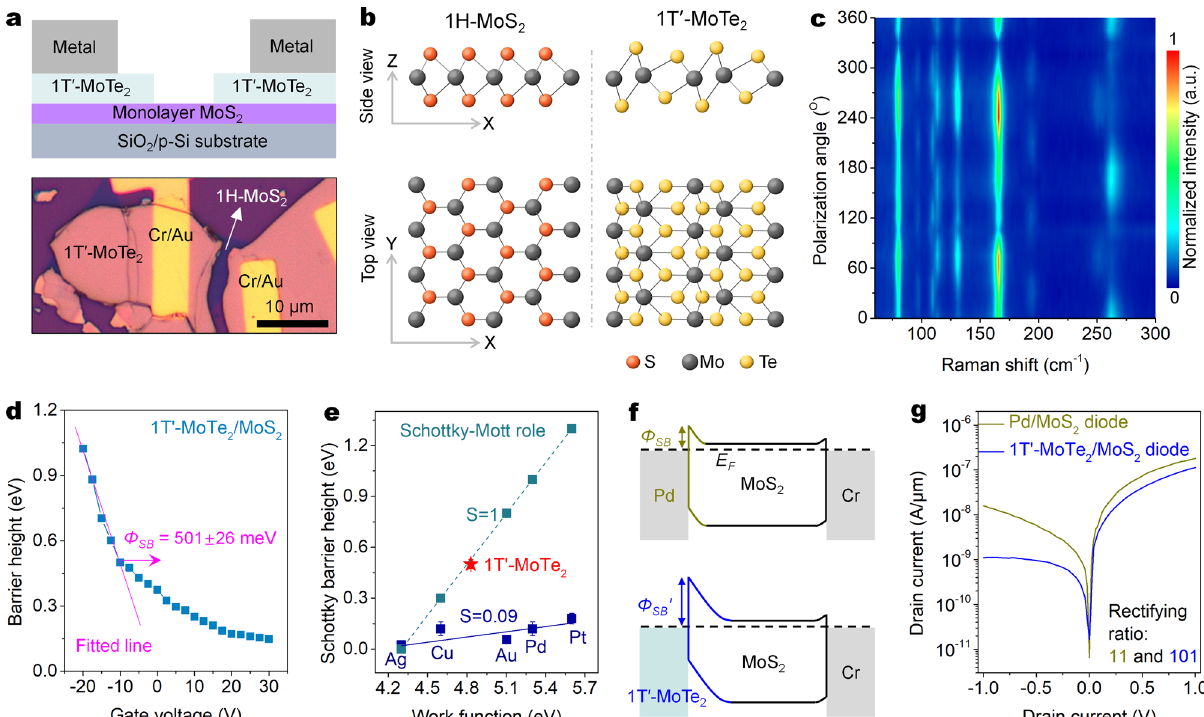
Fig. 2 The 1T ′ -MoTe 2 /MoS 2 Schottky junction with large Schottky barrier height and weak Fermi pinning effect. a Schematic diagram (top) and optical micrograph (bottom) of a monolayer MoS 2 FET with symmetric 1T ′ -MoTe 2 electrodes. b Crystal structures of the 1H-MoS 2 (left) and 1T ′ -MoTe 2 (right) monolayers. c Angle-resolved Raman spectra of the mechanically exfoliated 1T ′ -MoTe 2 fl ake. d Barrier heights of the 1T ′ -MoTe 2 /MoS 2 Schottky